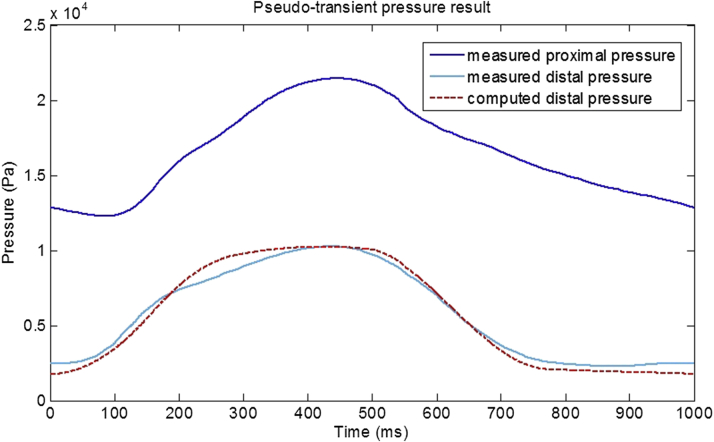
A Pseudotransient Pressure Result From an LAD Arterial CaseInvasively measured FFR was 0.350 and the computed vFFR was 0.346. The pseudotransient result closely matches the invasively measured result (RMS norm: 0.026), despite no transient data being used in its computation. RMS = root mean square; other abbreviations as in Figure 3.